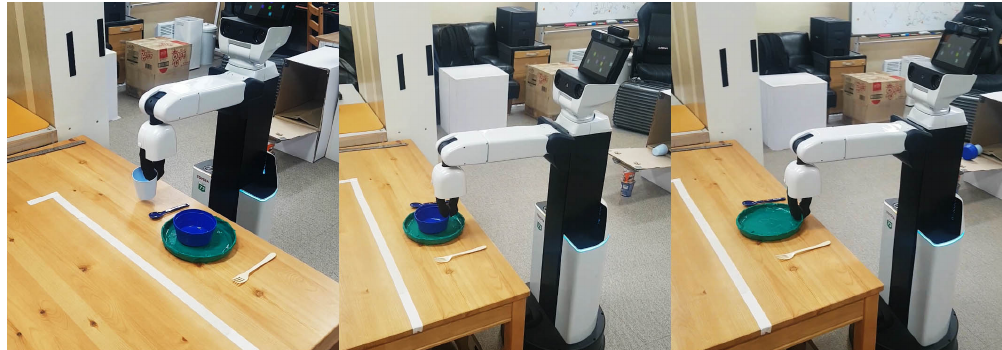
Figure 6. Detection and manipulation of previously unknown